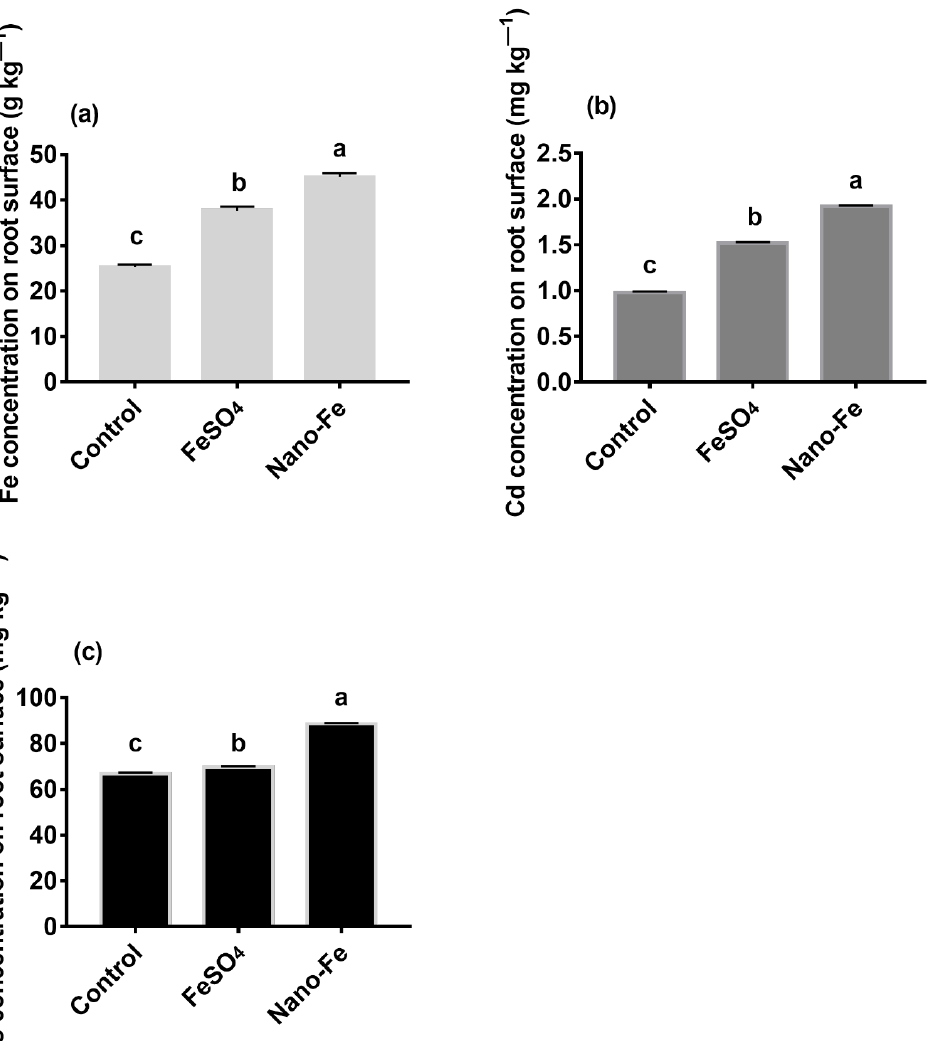
Figure 1. Concentrations of Fe ( a ), Cd ( b ), and As ( c ) on the surfaces of rice roots derived from treatments with exogenous Fe applied as FeSO 4 or Nano-Fe. Different lowercase letters in the columns indicate a significant difference among the different treatments at p < 0.05 .